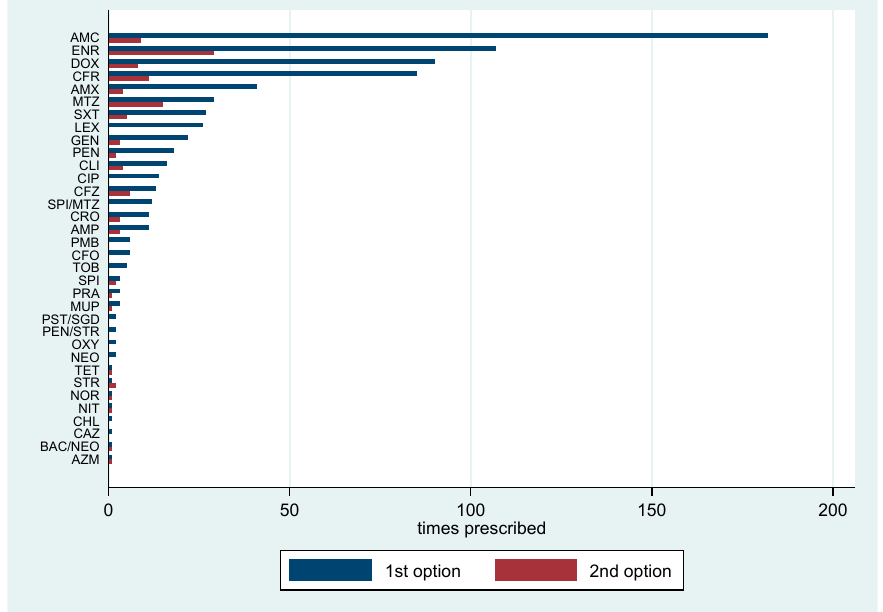
Figure 2. Antibiotics prescribed as first and second treatment options by respondents ( n = 859).